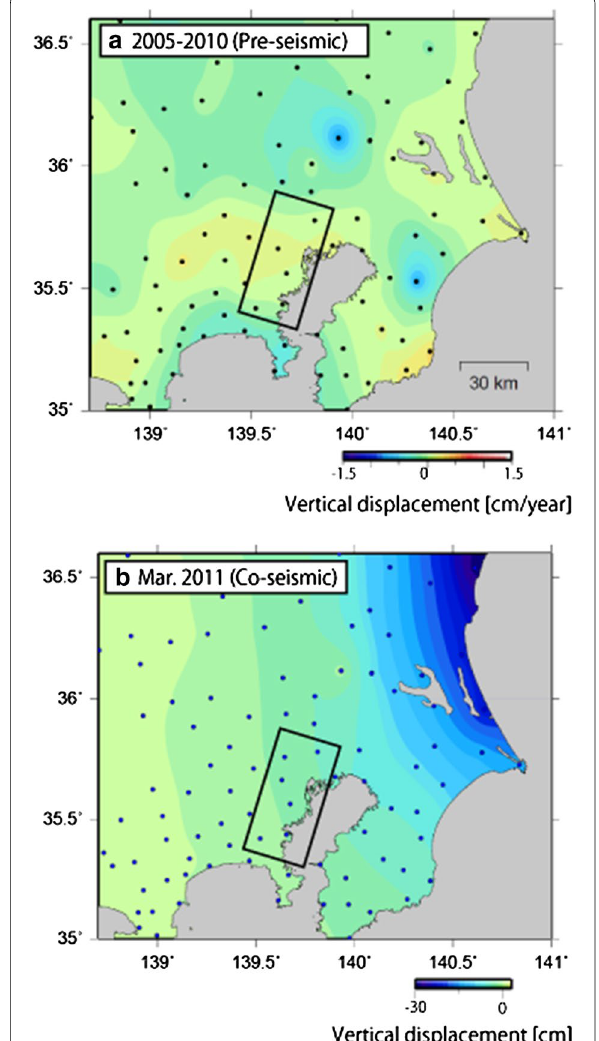
Fig. 2 a Annual vertical surface displacement velocity from January 2005 to December 2010 (the period before the 2011 Tohoku earth- quake), derived from the GPS network. b Vertical surface displace- ment from March 10, 2011, to March 12, 2011 (co-seismic period), derived from the GPS network. Black rectangles are the covered areas of TerraSAR-X